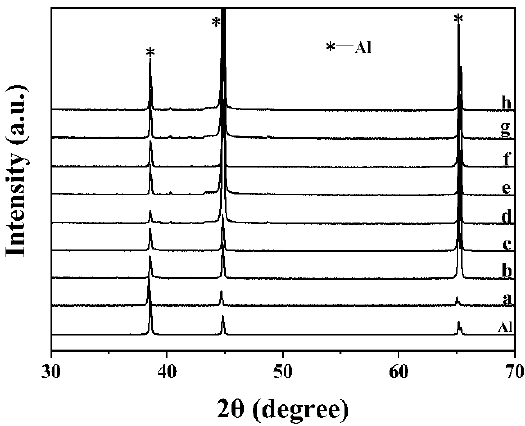
Figure 2. XRD spectrograms of the aluminum sheet surface: ( a ) after reaction with 300 °C of H 2 O(g); ( b ) after reaction with 400 °C of H 2 O(g); ( c ) after reaction with 500 °C of H 2 O(g); ( d ) after reaction with 600 °C of H 2 O(g); ( e ) after reaction with 700 °C of H 2 O(g); ( f ) after reaction with 800 °C of H 2 O(g); ( g ) after reaction with 900 °C of H 2 O(g); ( h ) after reaction with 1000 °C of H 2 O(g).